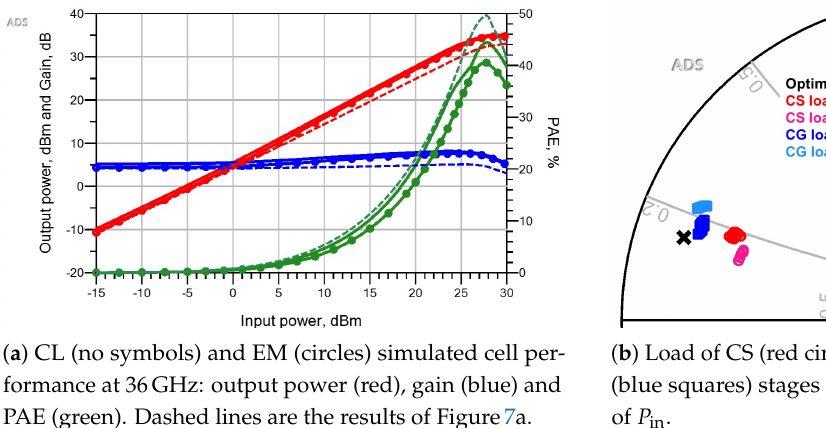
Figure 21. Comparison between CL and EM simulations for the L GS cell.